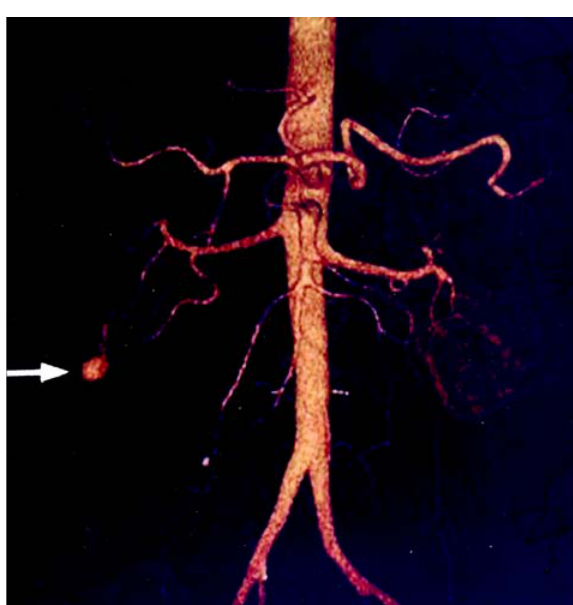
Figure 1 – Inferior pole segmental artery branch with pseudoaneurysm.